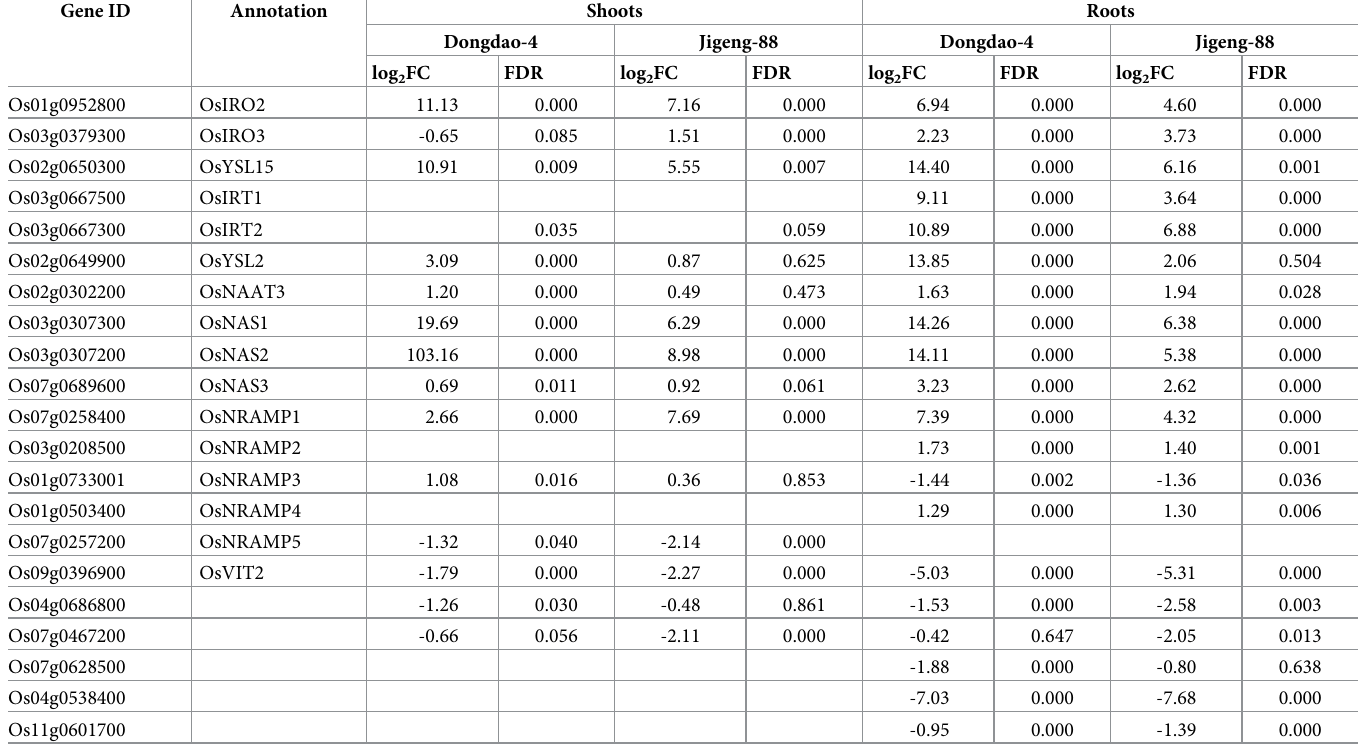
Table 4. Differentially regulated genes involved in iron homeostasis in Dongdao-4 and Jigeng-88 seedlings. Gene ID